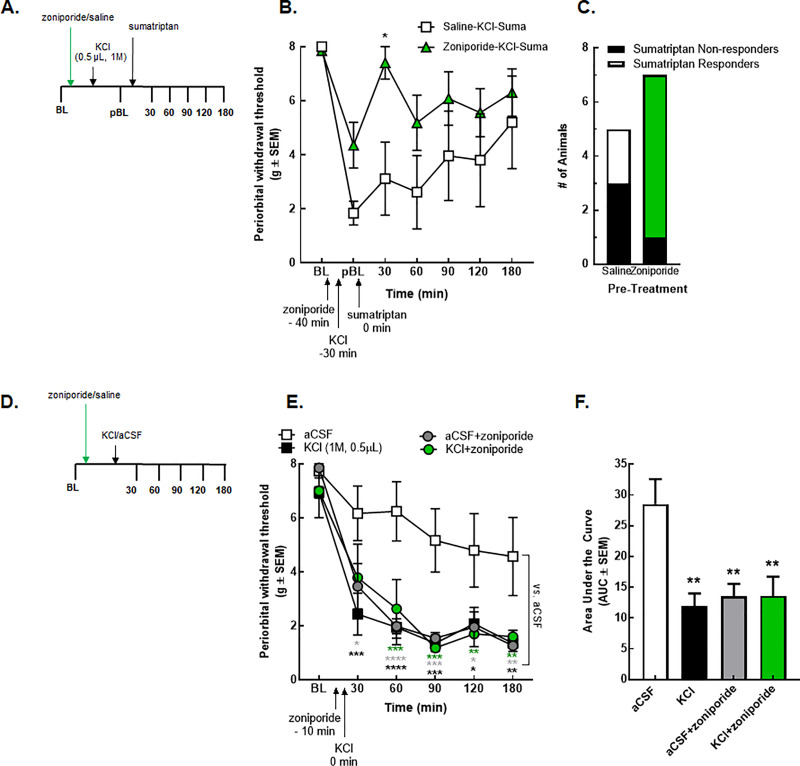
Systemic inhibition of NHE1 by zoniporide influenced the overall efficacy of sumatriptan but induced periorbital allodynia alone.(A) Timeline of the zoniporide-sumatriptan combination treatments. (B) Periorbital withdrawal threshold determined by von Frey test in rats treated with zoniporide (5 mg/kg, IP) or saline (1mL/kg, IP) in combination with sumatriptan (0.6 mg/kg, SC) and cortical KCl injection (0.5 μL, 1M). Values are the mean ± SEM (n = 5–10). * denotes significantly different (p<0.05) compared to post-baseline or saline-treated as assessed by two-way ANOVA. (C) Number of the sumatriptan responder and non-responder animals. (D) Timeline of the zoniporide-KCl/aCSF combination treatments. (E) Periorbital withdrawal threshold determined by von Frey test in rats injected with cortical KCl (0.5 μL, 1M) or aCSF (0.5 μL) with zoniporide (1 mg/kg, IP) or saline (1mL/kg, IP). Values are the mean ± SEM (n = 5–6). * p<0.05, ** p<0.01, *** p<0.001, and **** p<0.0001 compared to aCSF-treated as assessed by two-way ANOVA. (F) The area under the curve for the animals treated with aCSF/KCl ± zoniporide. Values are the mean ± SEM (n = 5–6). ** denotes significantly different (p<0.01) compared to aCSF-treated as assessed by one-way ANOVA.